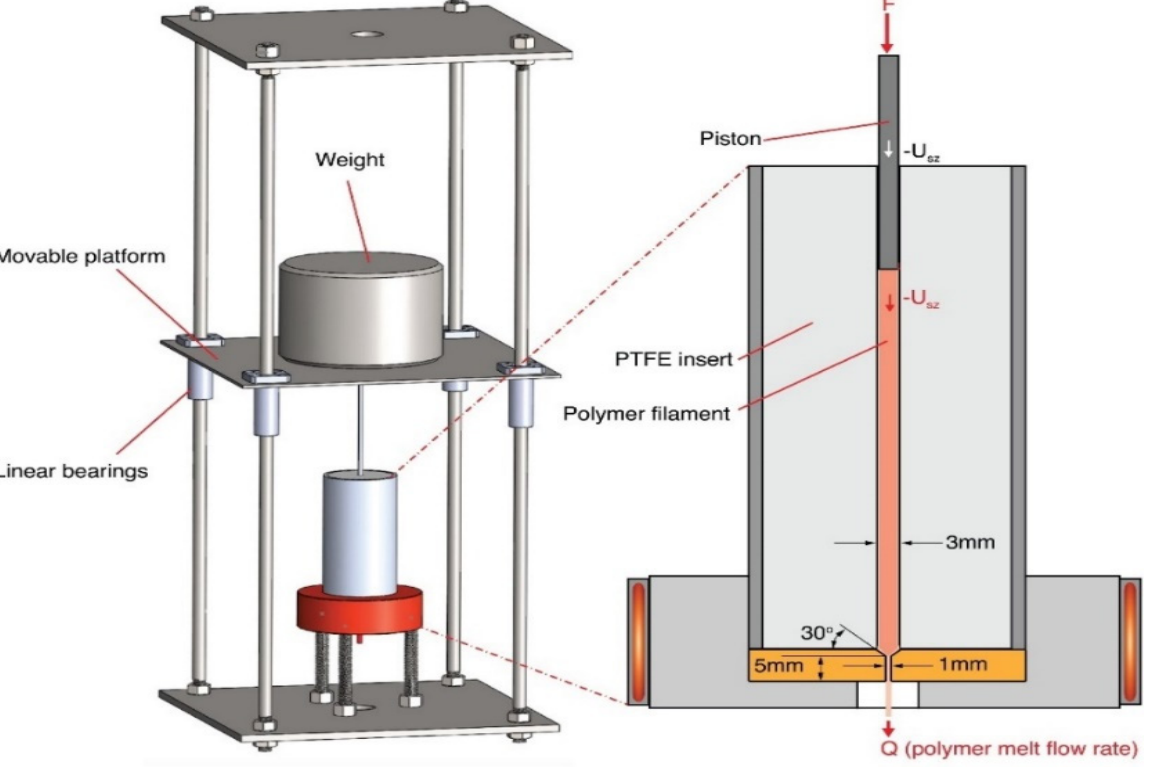
Figure 2. Experimental setup used for validation of the analytical model. Reprinted with permission from reference [32]. Copyright 2018, Elsevier.